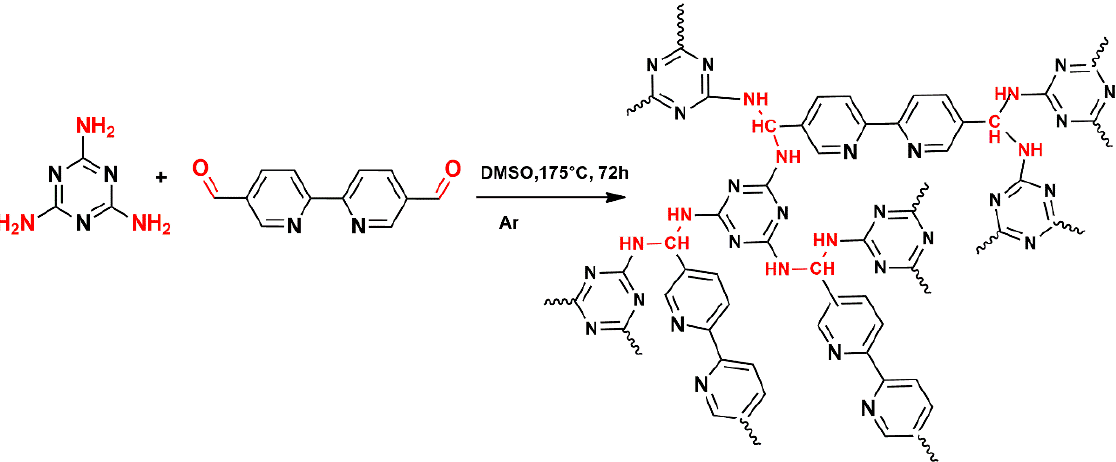
Scheme 1. Synthetic route for the preparation of bipyridine-based polyaminal network (Bipy-PAN).